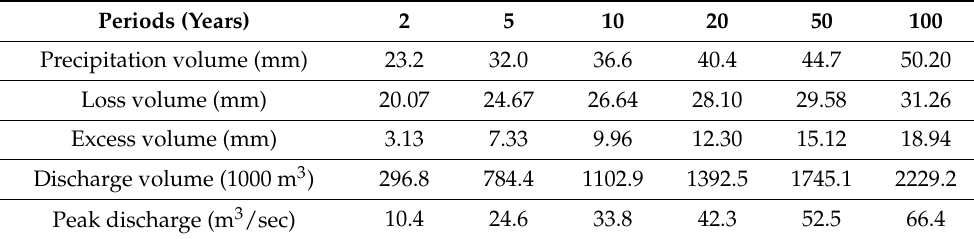
Table 9. Characteristics of the flood water of the Khazir River Basin for different return